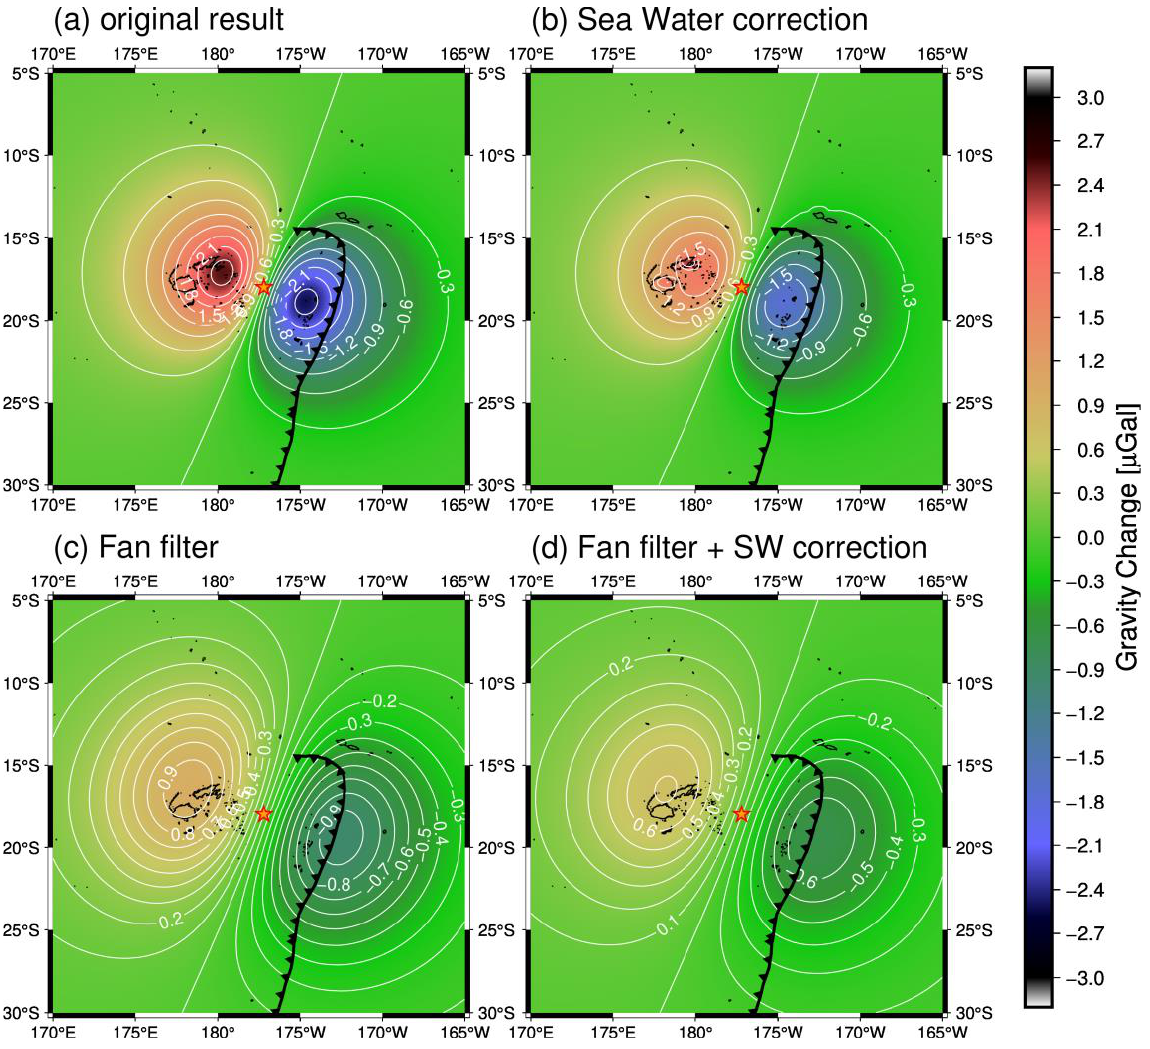
Figure 3. Calculated coseismic gravity changes based on fault parameters in Table 1. The red star marks indicates the estimated epicenter shown in Table 1. ( a ) The original result, to which no filters or corrections were applied. This is equivalent to the gravity change on the Earth without an ocean.